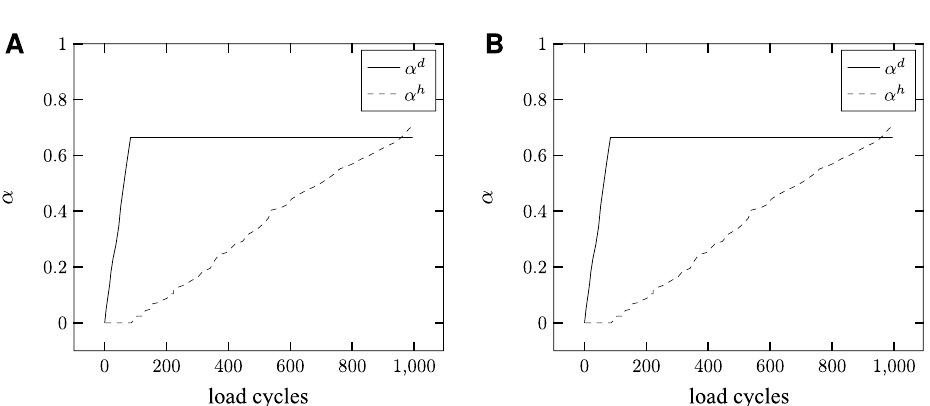
Fig. 6. Stress-strain diagrams for element 1 (A) and element 2 (B).